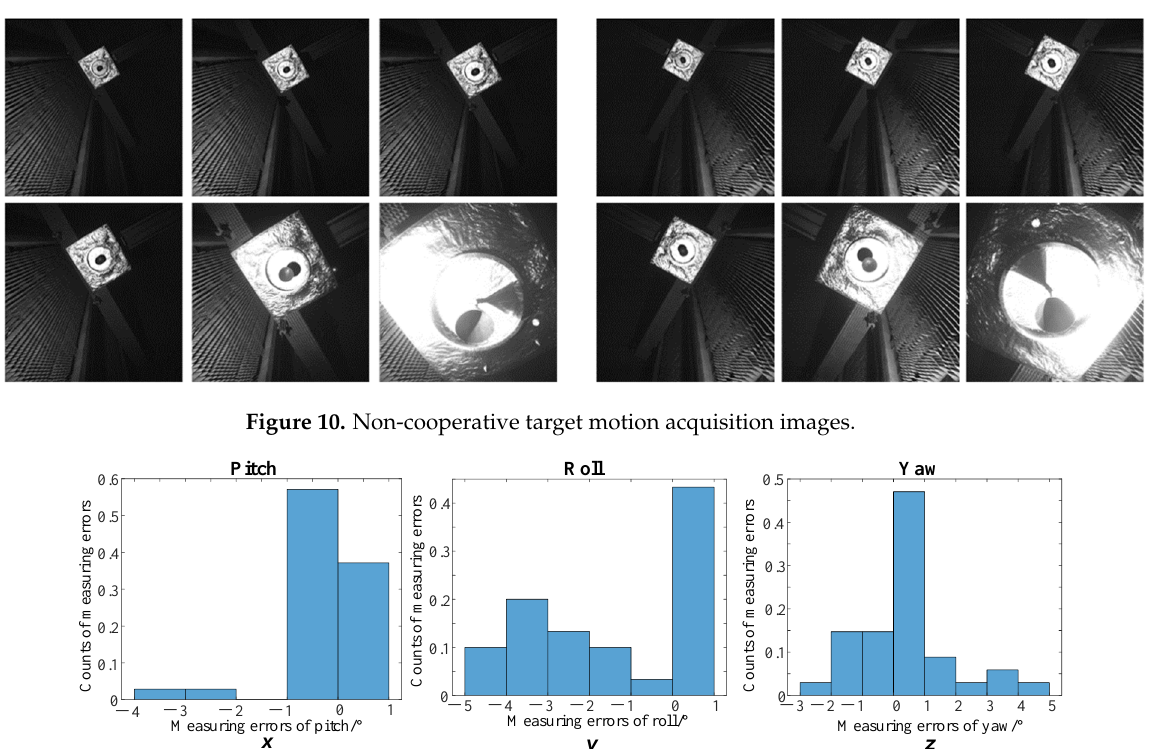
Figure 10. Non-cooperative target motion acquisition images.